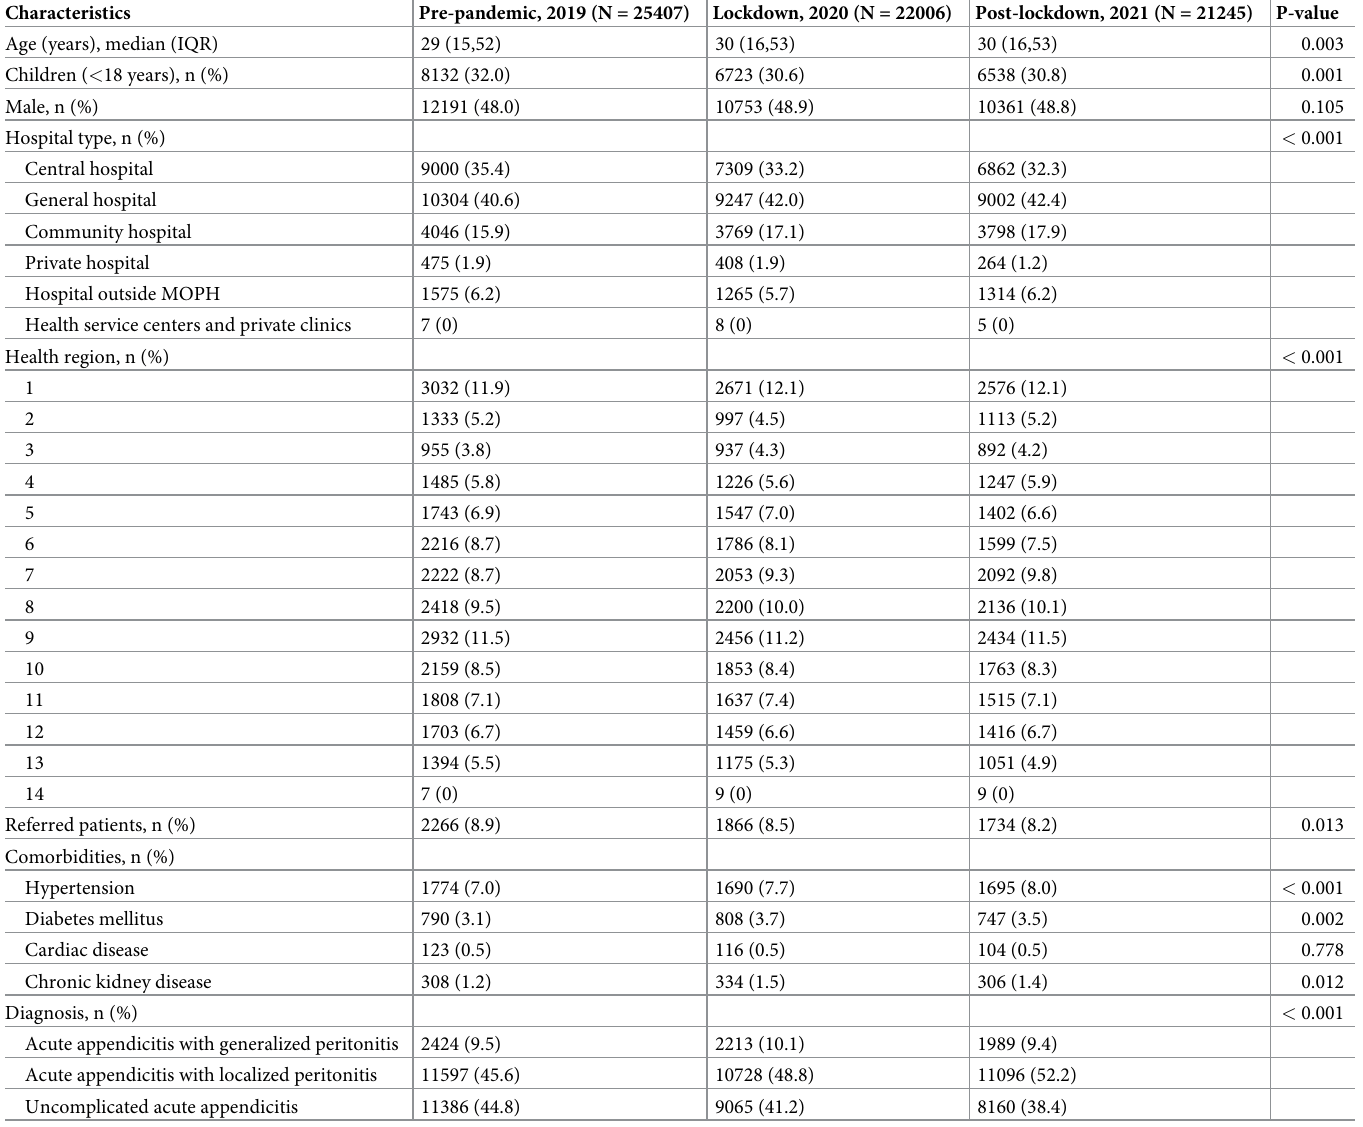
Table 1. Characteristics of patients with acute appendicitis during three study periods.